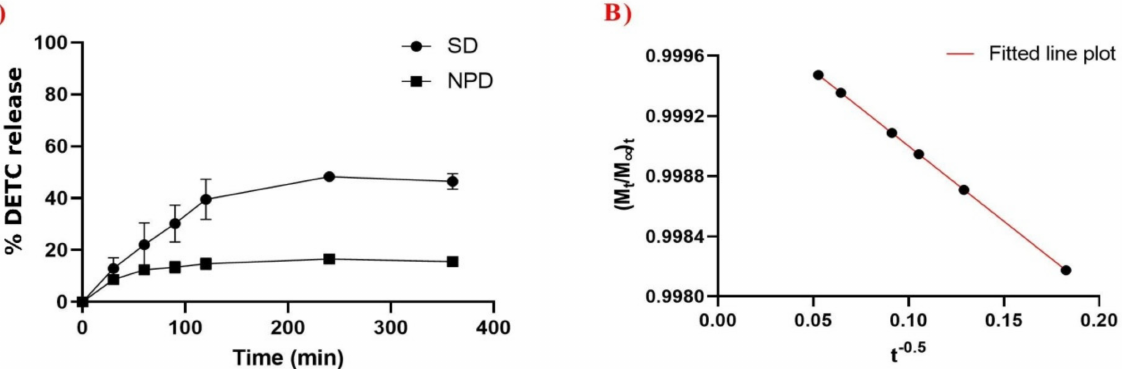
Figure 3. Experimental in vitro release profile. ( A ) Analysis of DETC solution (DS) and DETC-loaded nanoparticles (NPD) at the same time intervals and conditions. Results presented as mean ± standard deviation in an independent triplicate system. ( B ) Parabolic model of NPD during performed assays. The dots are the points obtained by equation to determinate the R score.